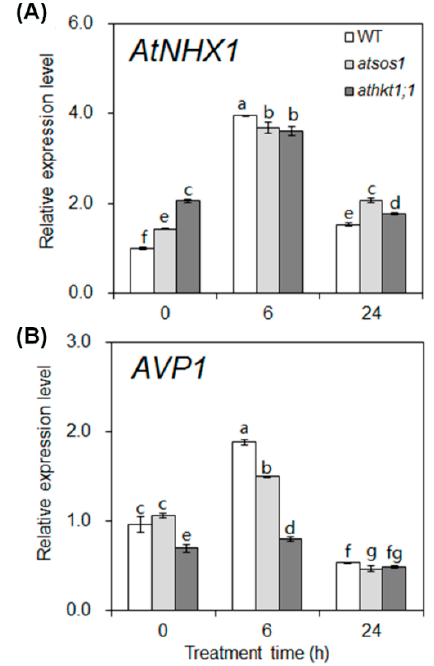
Figure 4. Na + and K + transporter gene expression in WT, atsos1 , and athkt1;1 shoots exposed to 25 mM NaCl at different times. Quantitative RT-PCR analysis of AtNHX1 ( A ) and AVP1 ( B ) mRNA in shoots of 6-week-old WT, atsos1 , and athkt1;1 that were treated with 25 mM NaCl for 0, 6, and 24 h. ACTIN was used as an internal control. Values are means ± SE ( n = 9), and bars indicate SE. Columns with different letters indicate significant differences at p < 0.05 (Duncan’s test).